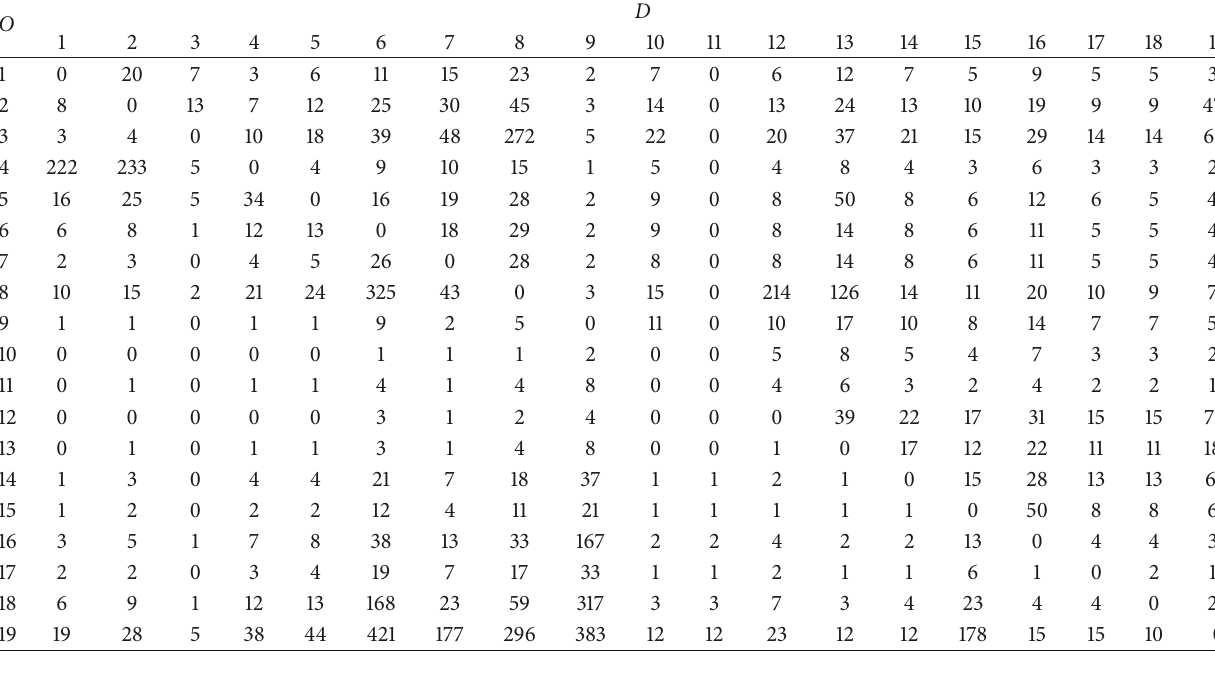
Table 4: Start stops and end stops of feasible strategies. Strategies